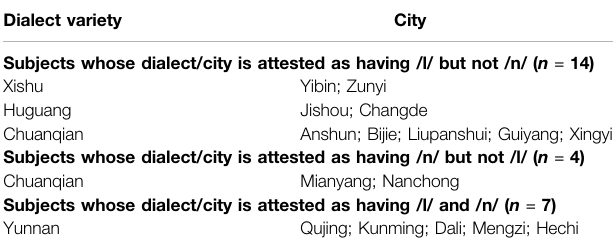
TABLE 1 | Subjects ’ dialect variety and